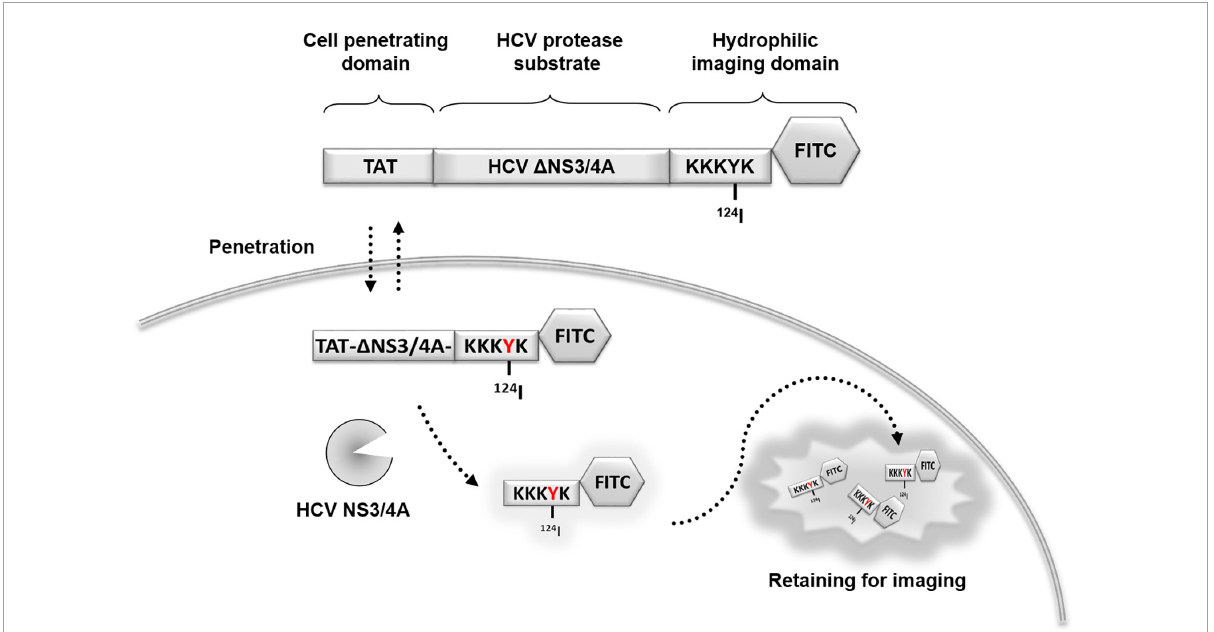
FIGURE1 Schematic representation of the protease-activated retention micro-PET probe. Hepatitis C virus (HCV) tracking probe was designed using HCV NS3/4A serine protease as a marker of viral activity. A cell-penetrating probe was designed that consisted of a cell-penetrating Tat peptide, a HCV NS3/4A protease substrate, and a hydrophilic domain. For imaging, the probe was labeled by fluorescein FITC and 124 I in the hydrophilic domain to form a TAT- (cid:49) NS3/4A- 124 I-FITC probe. Upon cleavage at NS3/4A substrate, the non-penetrating hydrophilic domain is released and accumulated in the cytoplasm allowing visualization using PET or optical imaging. NS, non-structural protein; TAT, transactivator of transcription of human immunodeficiency virus; FITC, fluorescein isothiocyanate; HCV, hepatitis C virus; PET, positron emission